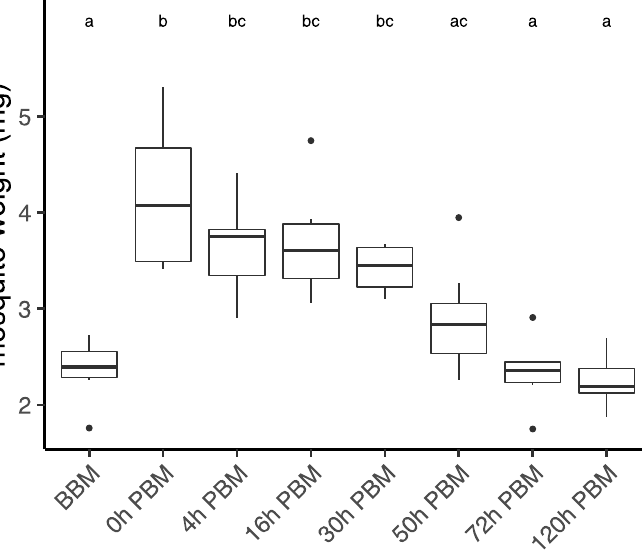
Figure 1. Weights of Aedes aegypti females across different time points over the course of feeding and reproduction. Weights were measured at eight time points before blood meal (BBM) and post blood meal (PBM). The same letter at the top of the boxplots represents groups that are not significantly different following Tukey HSD post-hoc tests. Dots represent